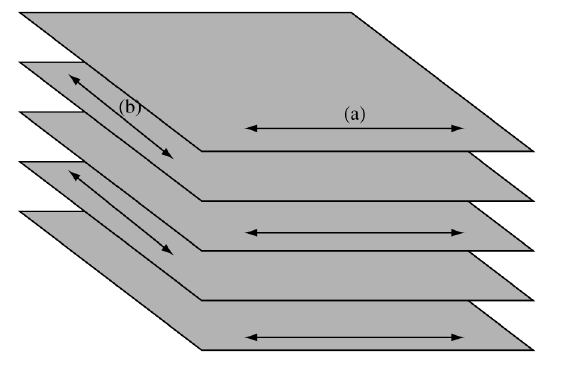
Figure 1. Position of layers in plywood. a) Direction perpendicu- lar to the grain of the external layers; b) Direction parallel to the grain of the external layers. Source: Keinert Jr. 12